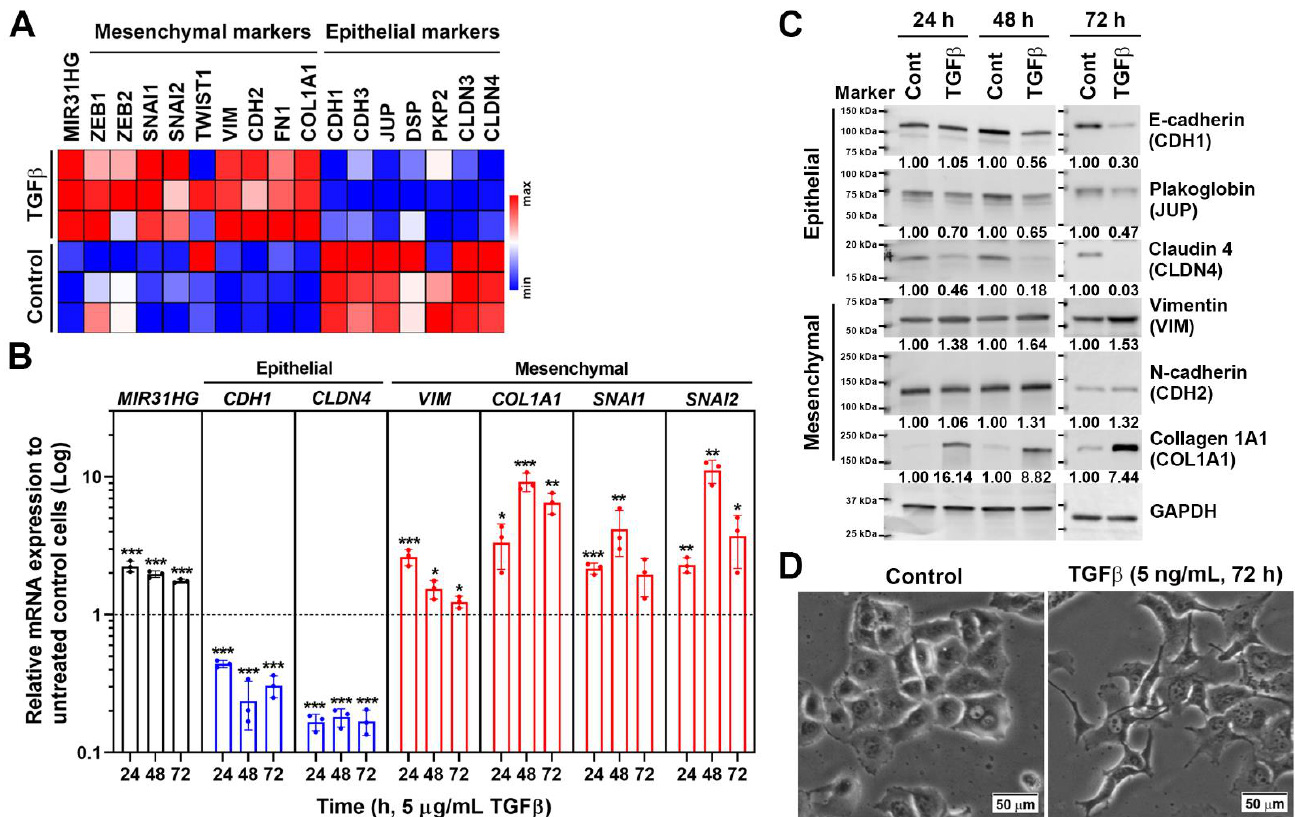
Figure 3. Transforming growth factor β (TGF β ) induced MIR31HG and the epithelial-to-mesenchymal transition (EMT) in PANC-1 cells: ( A ) A microarray dataset (GSE23952) for TGF β (5 ng/mL for 48 h)-treated PANC-1 cells was obtained from the GEO database. A heat map shows the relative expressions of MIR31HG and EMT markers; ( B ) PANC-1 cells were treated with 5 ng/mL TGF β for 24, 48, and 72 h. Total RNAs were examined by a real-time qPCR for MIR31HG and EMT marker expressions. Data represent the fold changes of mRNA expression (mean ± standard deviation, SD) for each gene compared to untreated control cells at each time point. * p < 0.05, ** p < 0.01, and *** p < 0.001 indicate statistical significance compared to untreated control cells; ( C ) PANC-1 cells were treated with 5 ng/mL TGF β for 24, 48, and 72 h. Total protein lysates were examined by Western blotting for EMT marker expressions. Representative images of each protein were obtained from the same or different blots. The band intensity was quantified and the related ratio to each time point was shown; ( D ) PANC-1 cells were treated with 5 ng/mL TGF β for 72 h. The cell morphology was observed under bright-field microscopy. Scale bar, 50 µ